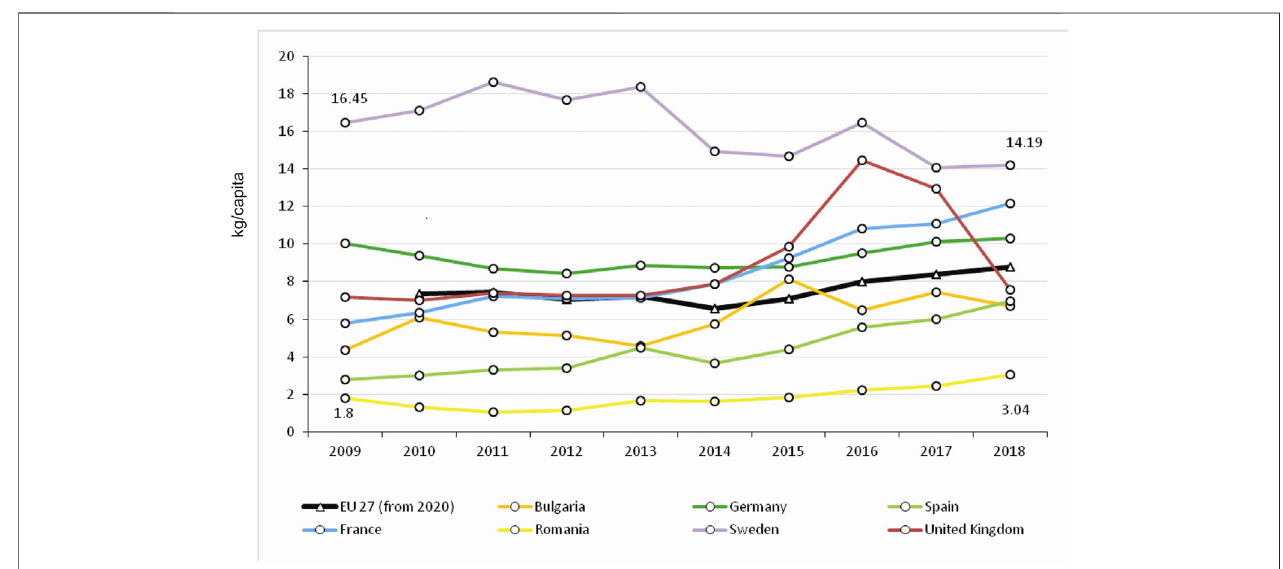
FIGURE 3 | E-waste treatment in selected EU countries, kg/capita (2009 – 2018)/Source: Own compilation from Eurostat data.